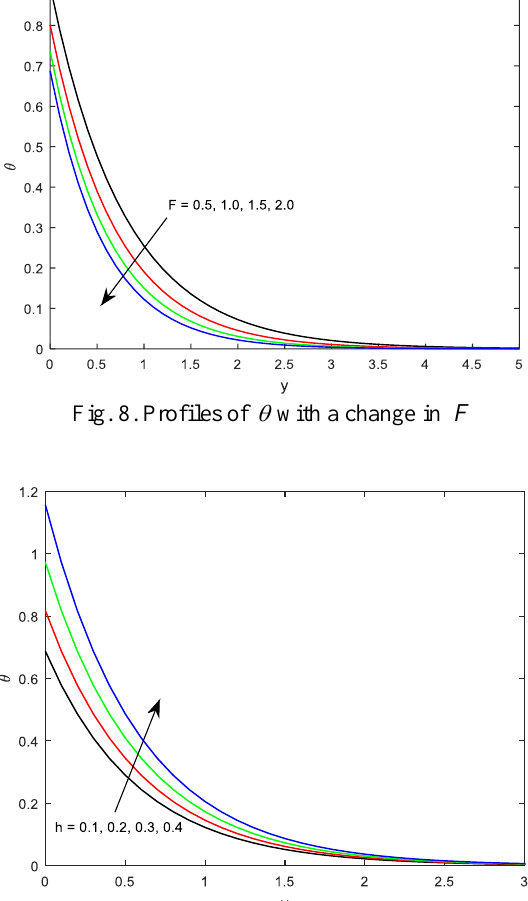
Fig. 7. Profiles of  with a change in